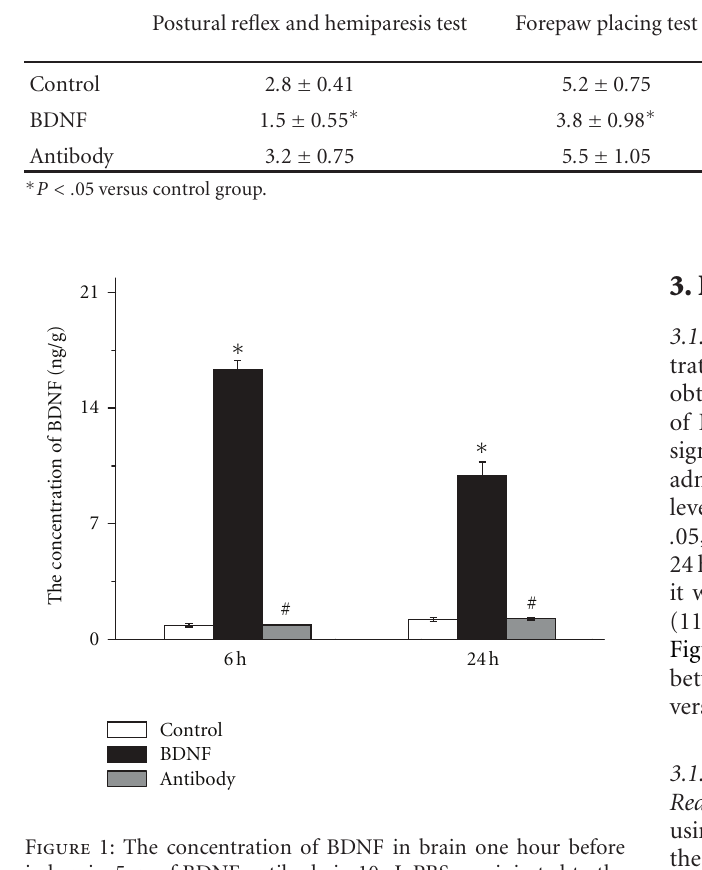
Figure 1: The concentration of BDNF in brain one hour before ischemia, 5 μ g of BDNF antibody in 10 μ L PBS was injected to the brain of rats. 10 μ g BDNF in 10 μ L PBS was given immediately after ischemia. At 6h and 24h of reperfusion, rats were sacrificed and brains were removed. The concentration of BDNF was measured after reperfusion using ELISA kits. The level of BDNF was significantly increased in BDNF group both 6h and 24h after reperfusion. Bars represent mean ± SD ( n = 6). ∗ P < . 05 versus control group, # P < . 05 versus BDNF